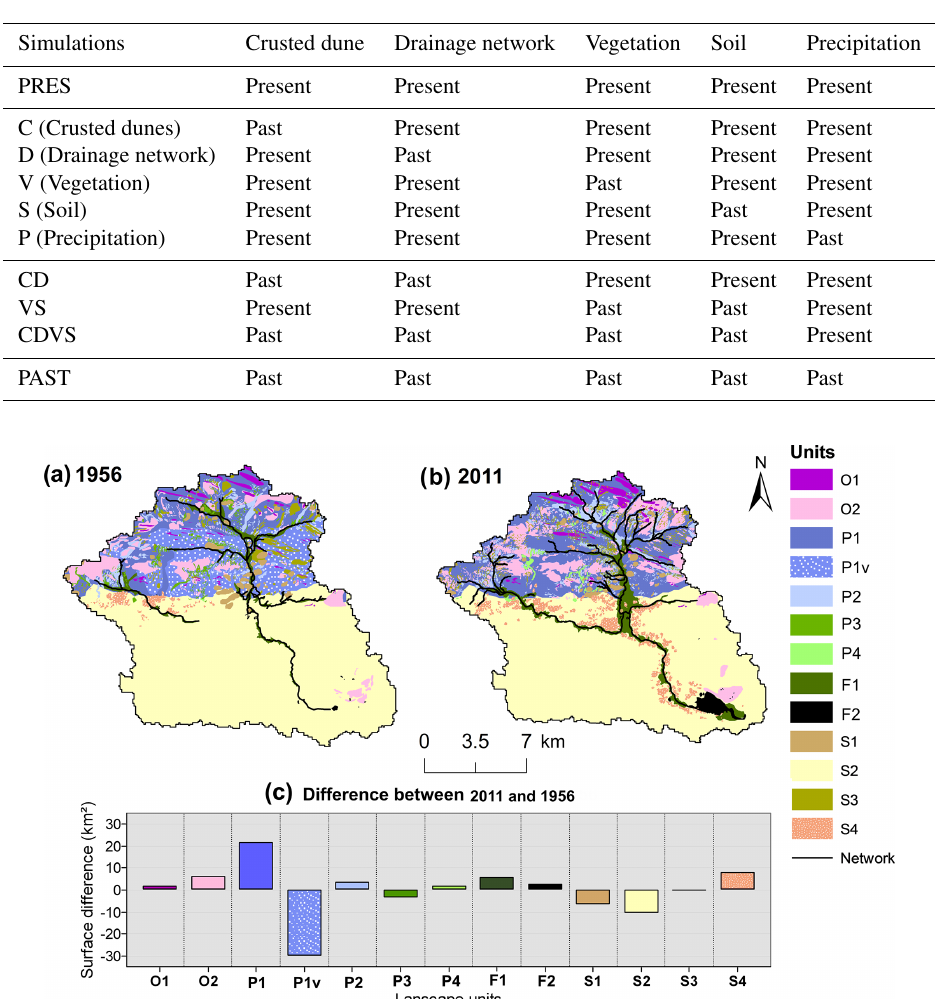
Figure 3. Land cover maps of the Agoufou watershed for (a) 1956, (b) 2011 and (c) gives the surface difference (in km 2 ) for each landscape unit, between 2011 and 1956.